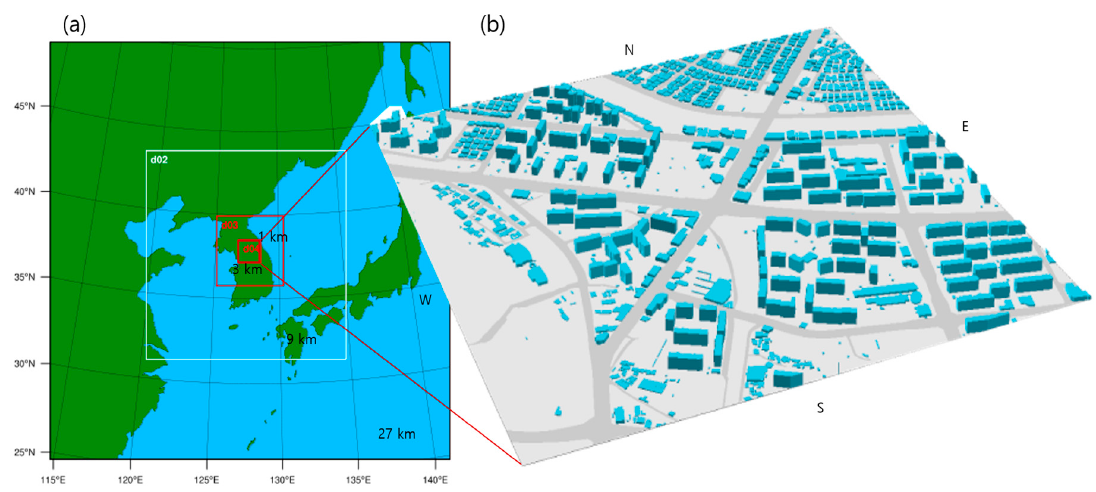
Figure 2. ( a ) Four nested domains in the WRF model and ( b ) a CFD model domain including the Toegye Intersection and the surrounding apartment and commercial buildings.